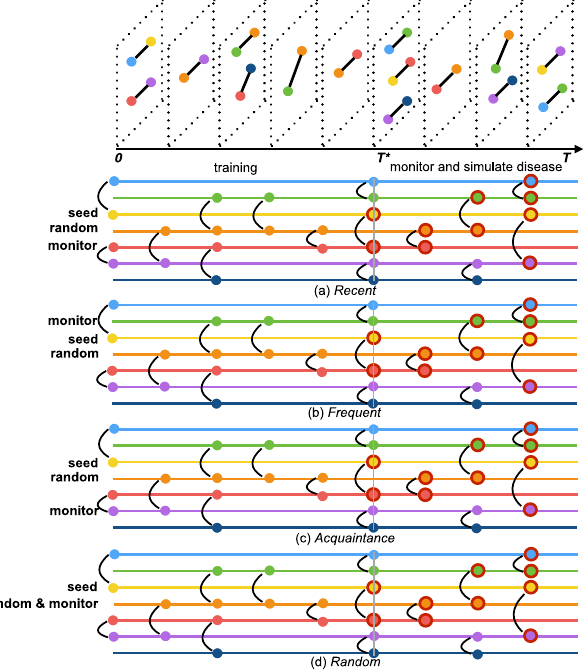
Figure 2. An illustration of our surveillance strategies. The top diagram illustrates a temporal network of contacts over a time window. There are two time windows, separated at three quarters(round down) of the sampling time, one for training and one for disease spreading simulation. In Panels (a–d), each horizontal line represents an individual and the circles and vertical lines indicate the interaction. The colors of the lines are the same as the vertex colors. The first infected node is marked “seed” and the interviewee selected randomly for information gathering is marked “random”. The sentinel represents selected neighbor of the interviewee selected according to different strategies. In the Acquaintance strategy, the orange red and green nodes can also be selected as sentinels. In the time window for disease spreading, red circle marks infected individual. The epidemic model in this example is the SI model with 100% infection